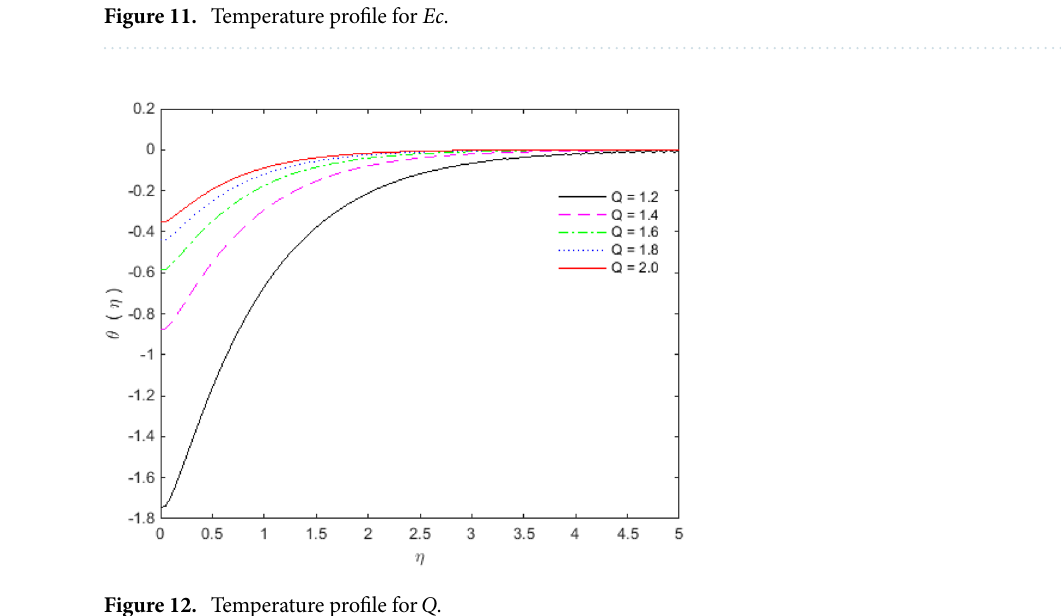
Figure 12. Temperature profile for Q .